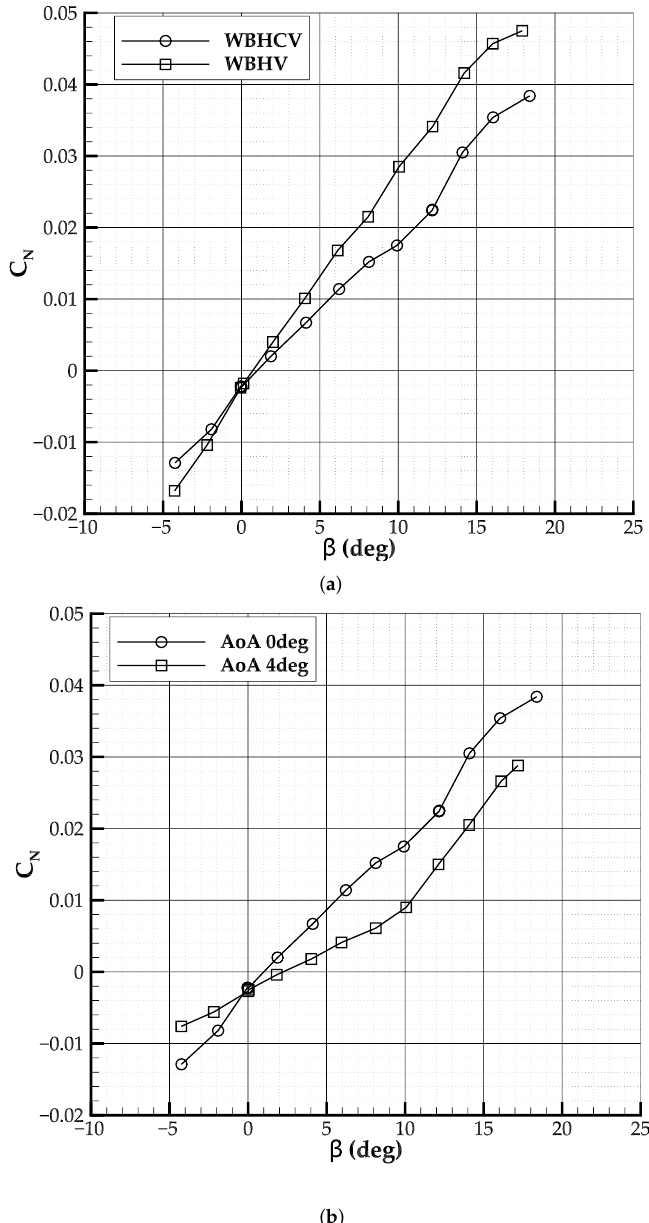
Figure 17. Effect of the canard and angle of attack on the yawing moment coefficient. Reference point at x CG = 0, V = 35m/s, Re = 315,000. ( a ) Effect of the canard at α = 0°. ( b ) Effect of the angle of attack on the WBHVC